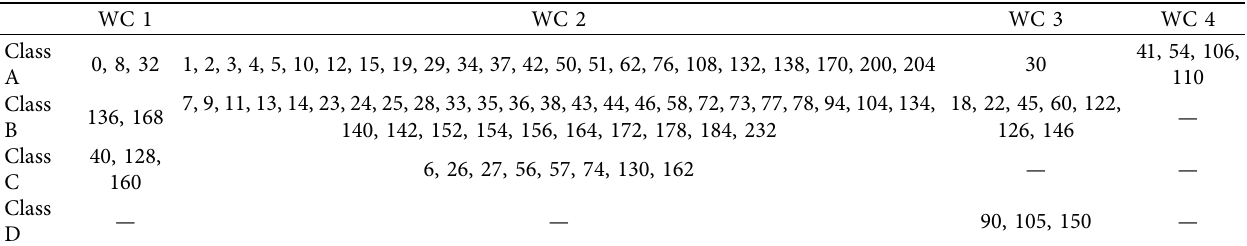
Table 2: Comparison of classes described above (Classes A to D, in rows) with the Wolfram classes (WC 1 to 4, in columns). WC 1 WC